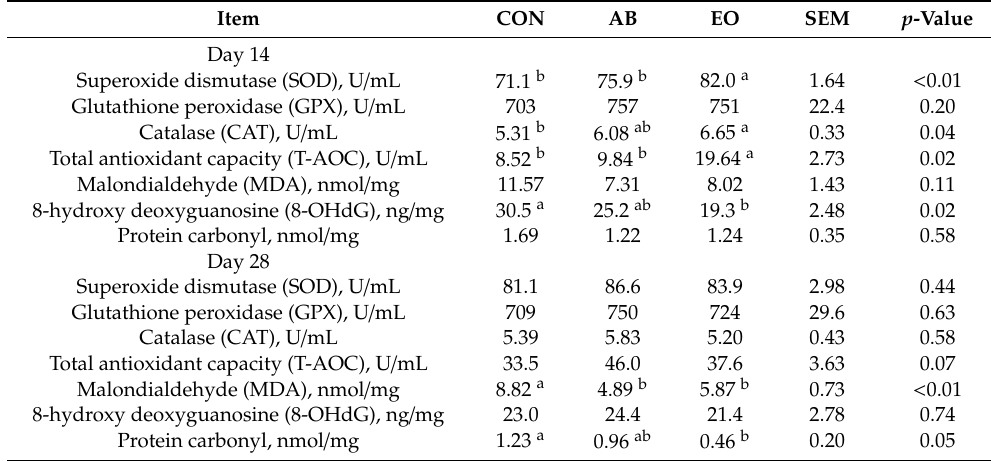
Table 6. E ff ects of essential oil supplementation on antioxidant enzyme activity and oxidant products of serum in weaned piglets 1 .